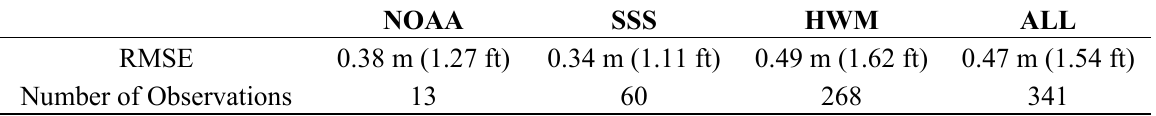
Table 12. Partition of relative error between observed and SLOSH-simulated maximum water elevation for all measurements: NOAA tide gauge stations and USGS storm surge sensors (SSS) and high water marks (HWM), cumulative (Cum) and individual (Ind). NOAA SSS Cum HWM Cum NOAA + HWM + SSS Relative Error % % % % Cum (Ind) (Ind) (Ind) Cum (Ind) ≤0.10 6 (6) 46 21 (21) 35 90 (90) 34 117 (117) 34 ≤0.20 9 (3) 69 40 (19) 67 192 (102) 72 241 (124) 71 ≤0.30 9 (0) 69 55 (15) 92 238 (46) 89 302 (61) 89 ≤0.40 11 (2) 85 60 (5) 100 254 (16) 95 325 (23) 95 ≤1.00 (>0.40) 13 (2) 60 (0) 268 (14) 341 (16) 100 Total 13 60 268 341 Table 13. Root mean square error between observed and SLOSH-simulated maximum water elevation for all measurements: NOAA tide gauge stations and USGS storm surge sensors (SSS) and high water marks (HWM), cumulative (Cum) and individual (Ind). NOAA SSS HWM ALL RMSE 0.38 m (1.27 ft) 0.34 m (1.11 ft) 0.49 m (1.62 ft) 0.47 m (1.54 ft) Number of Observations 13 60 268